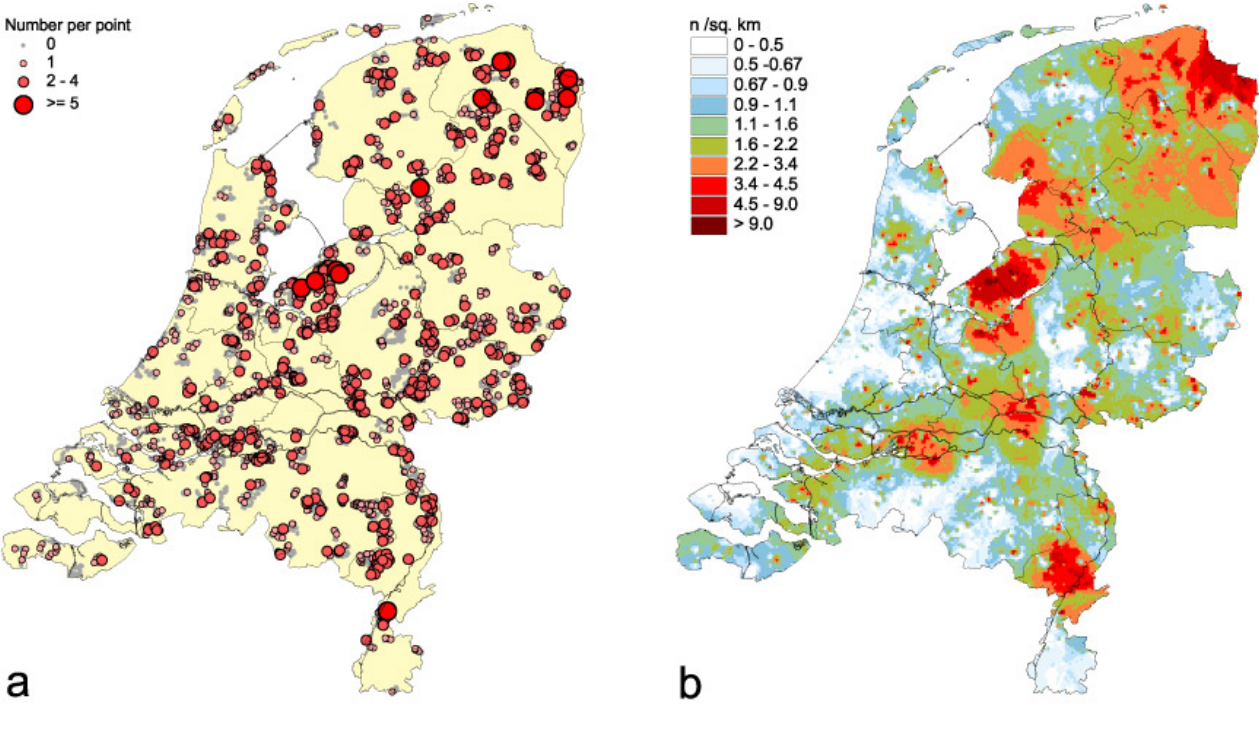
Fig. 2. (A) The number of common buzzards ( Buteo buteo ) observed per nonbreeding bird survey site in December 2000. The larger and darker the circle, the more birds per survey site. (B) The modeled buzzard density distribution, i.e., number of birds per km². The modeled distribution was created using regression-kriging, further described in the methods section (see also Fig. 1 and steps 1–3 in Table